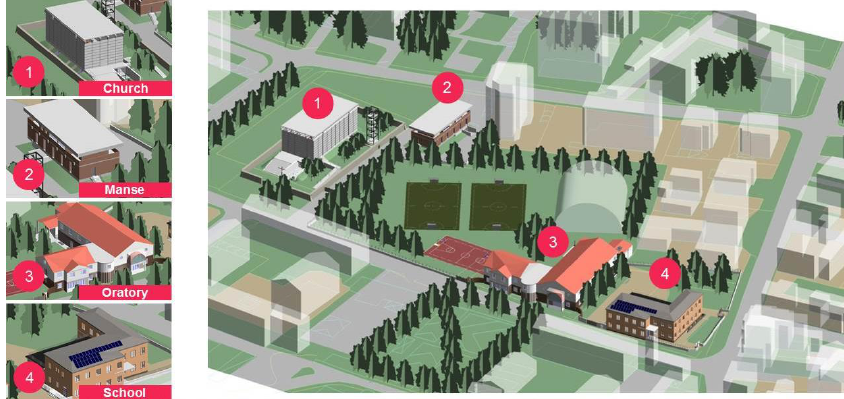
Figure 6. Case study real estate geometric modelling.